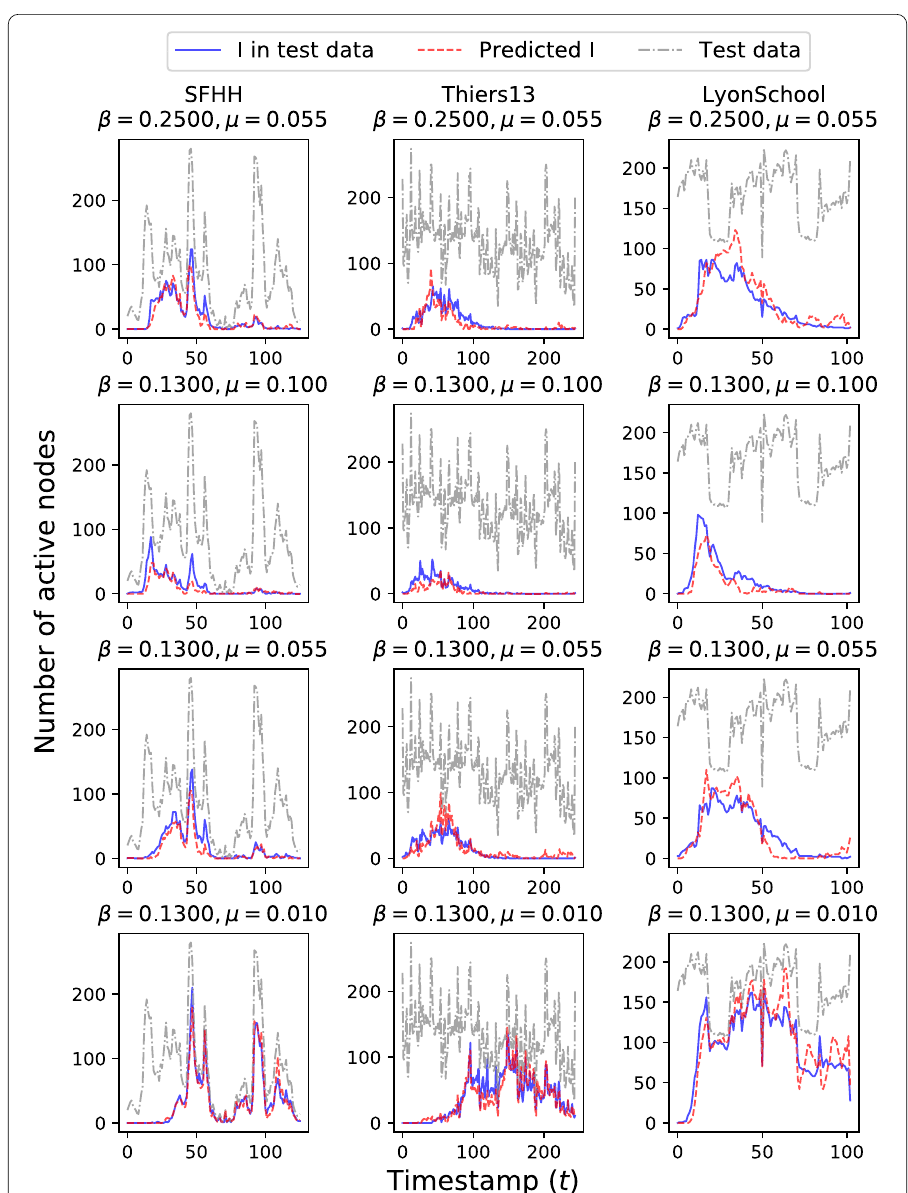
Figure 5 Example of predicted timelines of the number of active nodes in the infectious state, for several data sets and ( β , μ ) parameter values, for the dyn-supra + DeepWalk method. The blue, red and gray lines are respectively the number of actual active nodes in state I in the test data, the number of predicted active nodes in state I and the number of active nodes in the test data at time t . Note that the number of active nodes in the test data is almost the same as the total number of active nodes, as the training data is of small size ( ρ = 1, i.e., | D | = | V | )